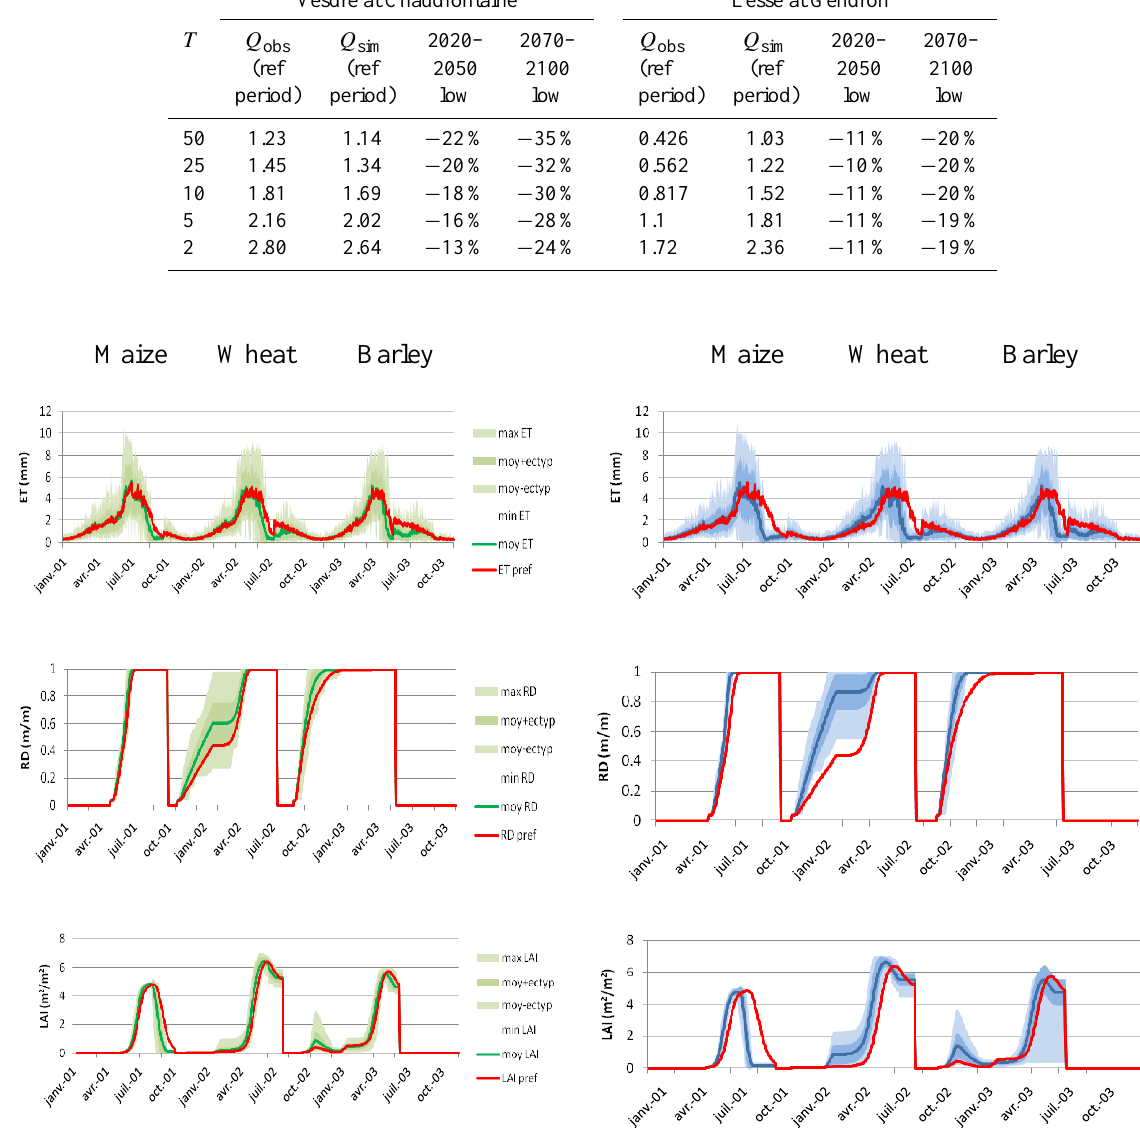
Fig. 7. Evolution of actual evapotranspiration (ET), root depth index (RD) and leaf area index (LAI) for 3 crops (maize, wheat, barley) for the end of the 21st century under the climate change scenario generated by CCI-HYDR low (left panel) and CCI-HYDR high (right panel). (Respectively actual evapotranspiration, root depth index and leaf area index on y-axis, time on